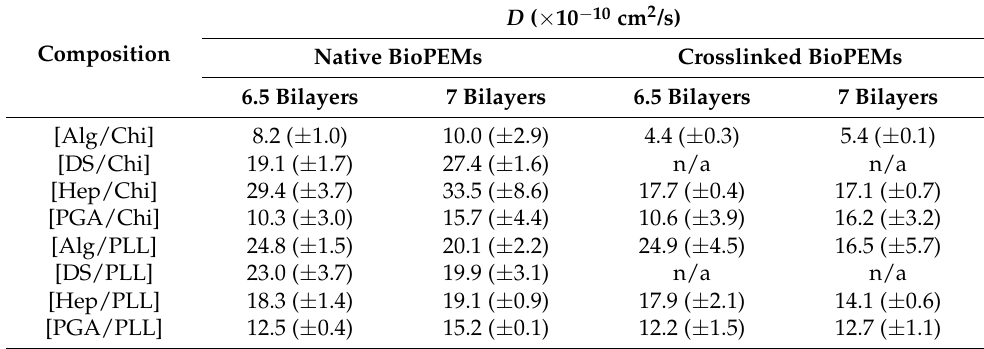
Table 2. Diffusion coefficients (D) of glucose through various